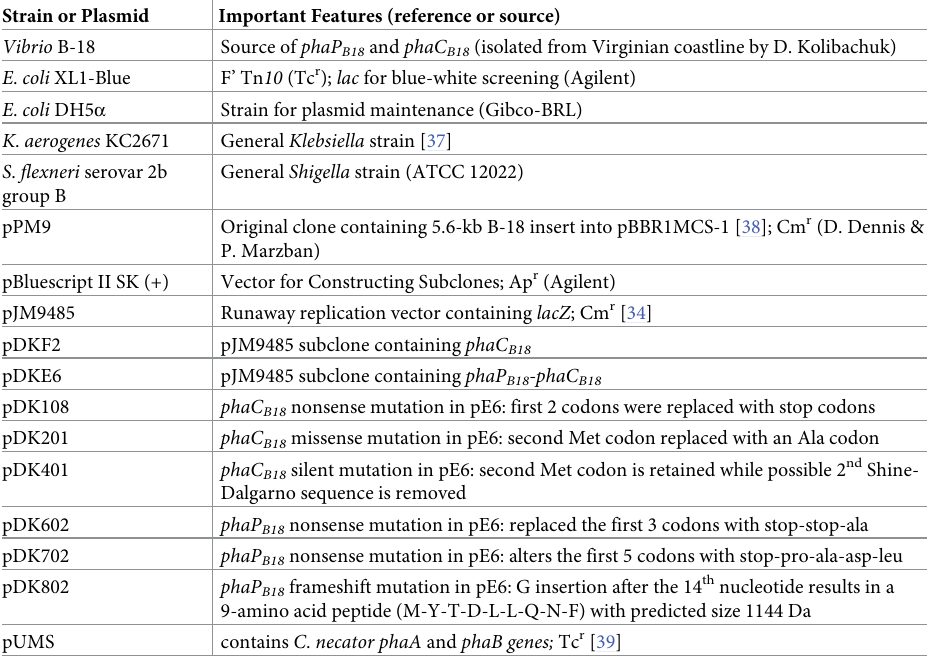
Table 1. Bacterial strains and plasmids used in this